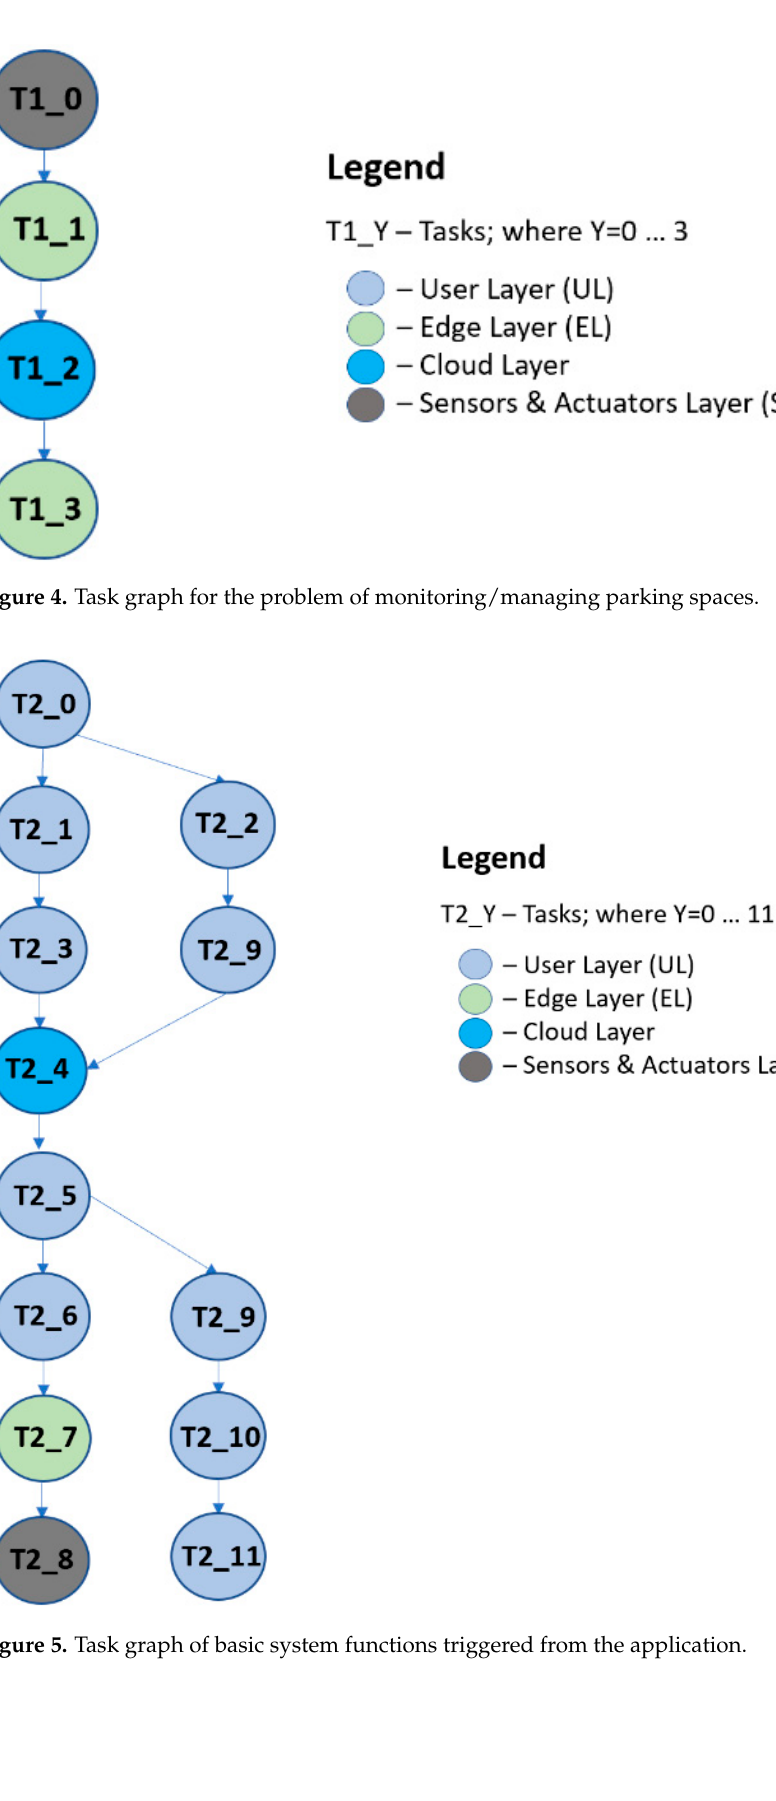
Figure 6. Task graph for the problem of collecting/updating data on weather conditions. For all system functionality, the starting point, or trigger (T0_0), is the end-user ac- tivity in a dedicated application made by selecting the appropriate function at the UL layer level. Depending on the selected function, a further sequence of events follows. When the user selects the parking space search function (T0_1), the user’s current loca- tion is retrieved using the GPS module (T0_4). If the car search function (T0_2) is selected, the user must enter the license plate number of the searched vehicle (T0_10) into the ap- plication. On the other hand, when the function of reserving a free parking space is se- lected from the user’s application (T0_03), the end user enters data/criteria for the search function, such as city and street (T0_12). The user also has the ability to download in- formation on weather conditions (T0_17). In the next step (T0_5), the central server (a dedicated cloud application running in the CL layer) receives queries from the UL layer and starts the processes necessary to perform the called functions. For example, data-